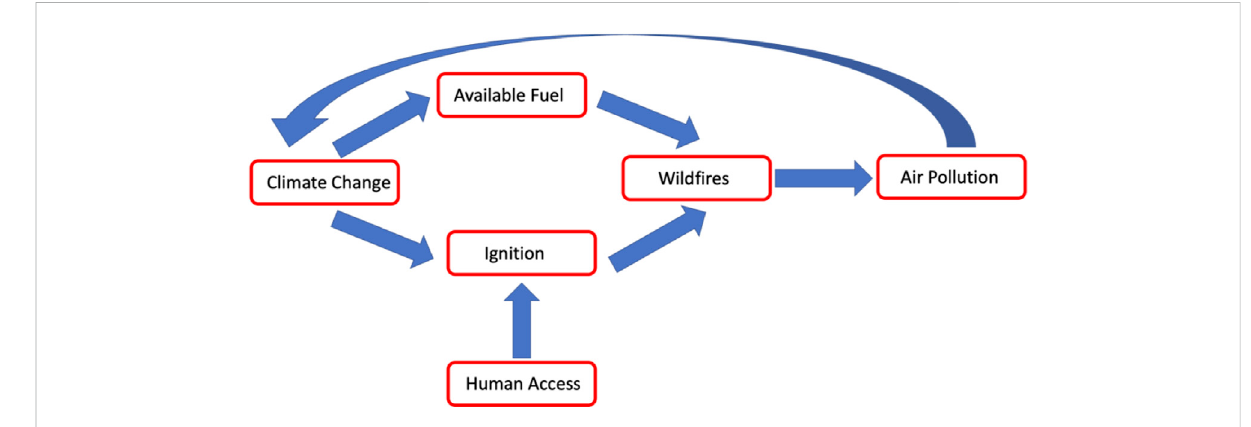
FIGURE 4 Feedback between climate change and wild fi res adopted from Fischer et al.